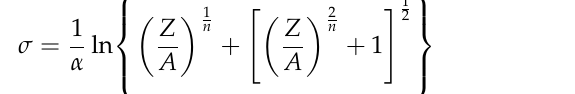
Figure 4. The relationship between ln Z and ln[sinh( ασ )].